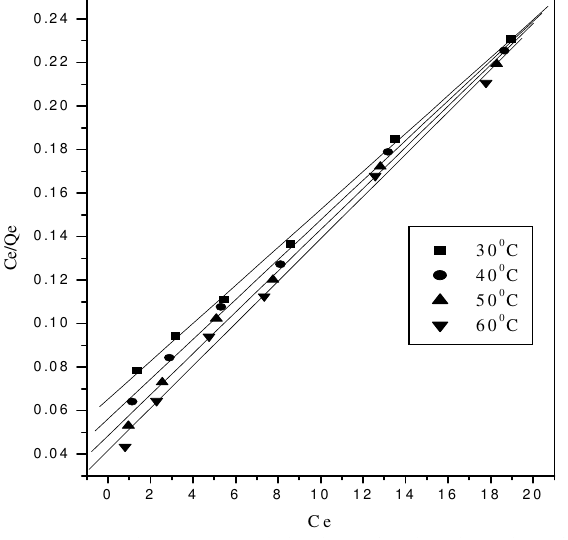
Fig.3-Linear Langm uir isotherm for the adsorption of Figure 3 . Langmuir isotherm for the adsorption of RDB onto